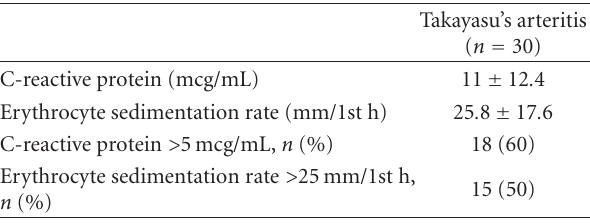
Table 3: Inflammatory markers in patients Takayasu’s arteritis. Values are expressed in mean ± SD or percentage